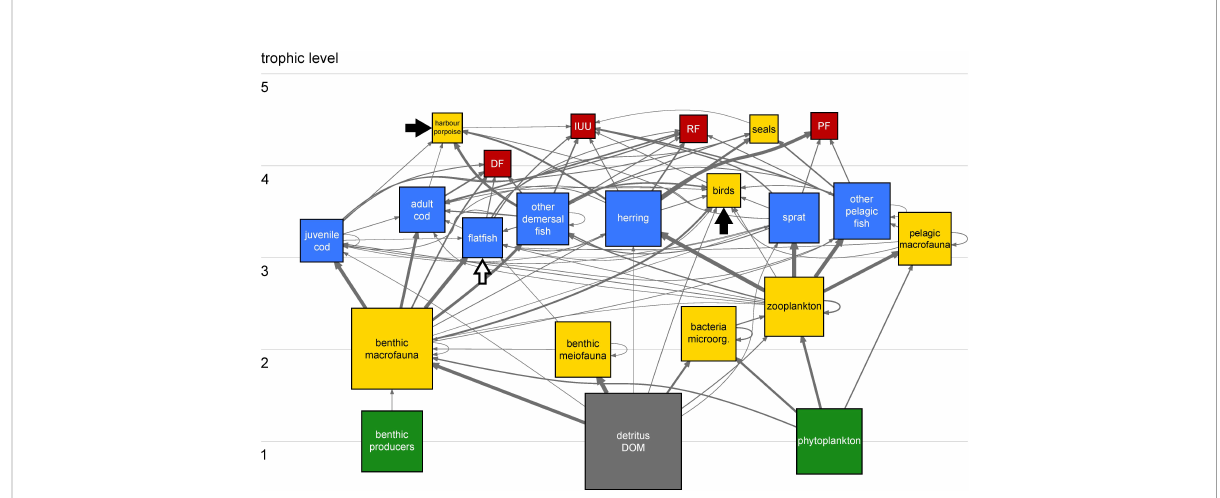
FIGURE 2 Carbon fl ow network of the WBS ecosystem in 1994. Trophic groups and fi sheries are represented by 22 squares/compartments (17 living, one non-living and four fi sheries) and interconnected by 99 links/ fl ows. Color codes for the compartments: primary producers, green; fi sh, blue; non- fi sh, yellow; non-living, grey; and fi sheries, red. Compartments are ordered vertically according to the effective trophic level (Scotti et al., 2006) and their size is proportional to the biomass on a log 10 scale, except for fi sheries. Grey, arrowheaded links indicate carbon fl ows from donor compartments (e.g. prey and resources) to receiving compartments (e.g. predators and consumers). Strength of fl ows is proportional to feeding preferences of consumers. Black and white arrows indicate import of food (harbour porpoises, birds) and immigration ( fl at fi sh) from adjacent ecosystems, respectively. Note that their size here is not proportional to their intensity. Table S9 provides size of all fl ows in the network in absolute numbers. Herring occupies a crucial position for transferring carbon from zooplankton to higher trophic levels and to fi sheries, with the latter extracting about 89% of carbon fl ows leaving the herring